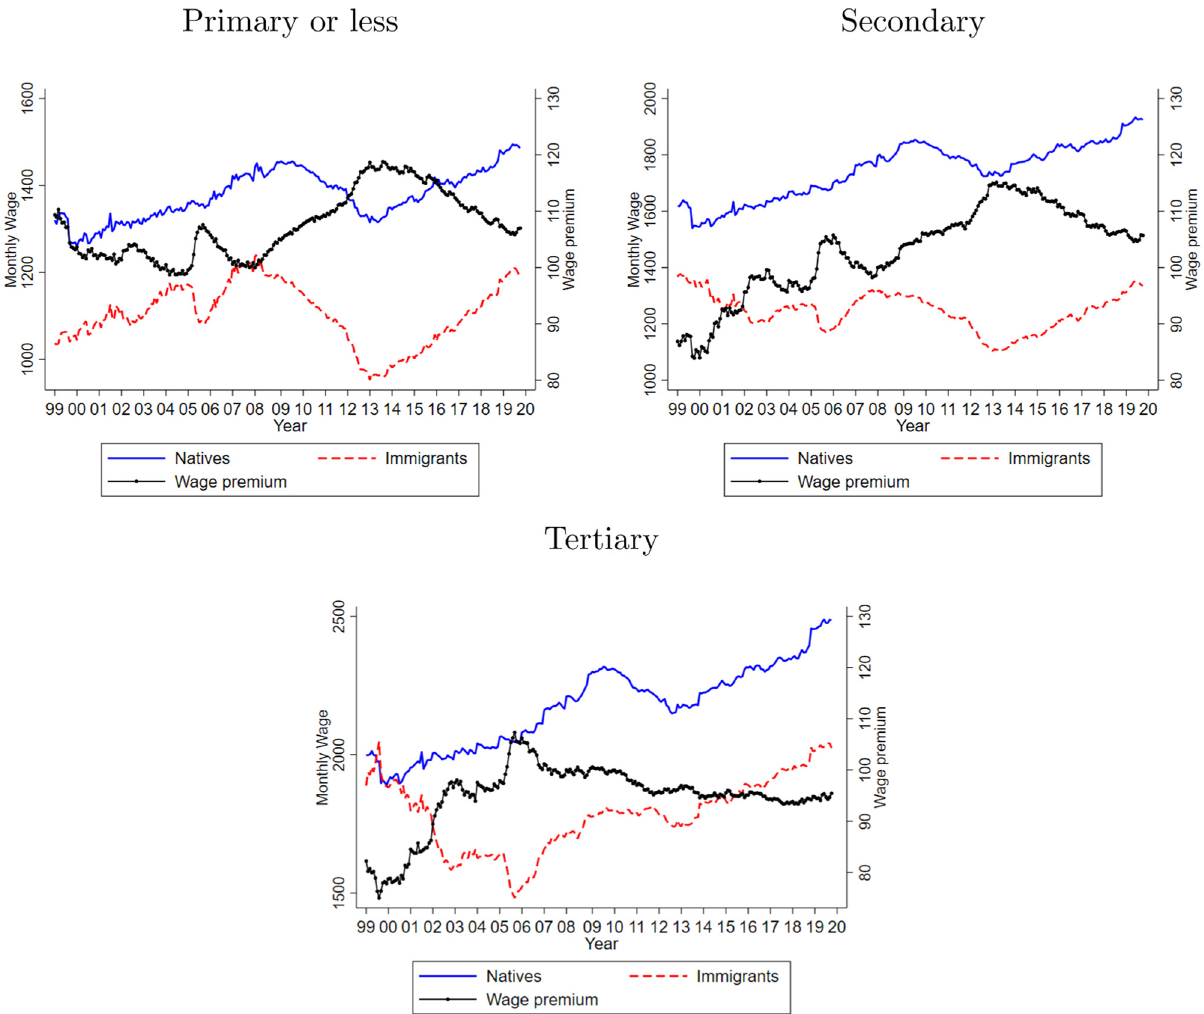
Figure A10: Monthly average wage by nationality and education attainment. Note: The wage premium is computed as ( ) / w w ¯ ¯ − 1 N t M t , , , where w ¯ j t , is the monthly average wage for natives = j N and immigrants = j M at month t . Wage premium is normalised to 100 at 2008Q1. Wages are seasonally adjusted by taking out the coe ffi cient of the monthly dummies from an OLS regression. Source: